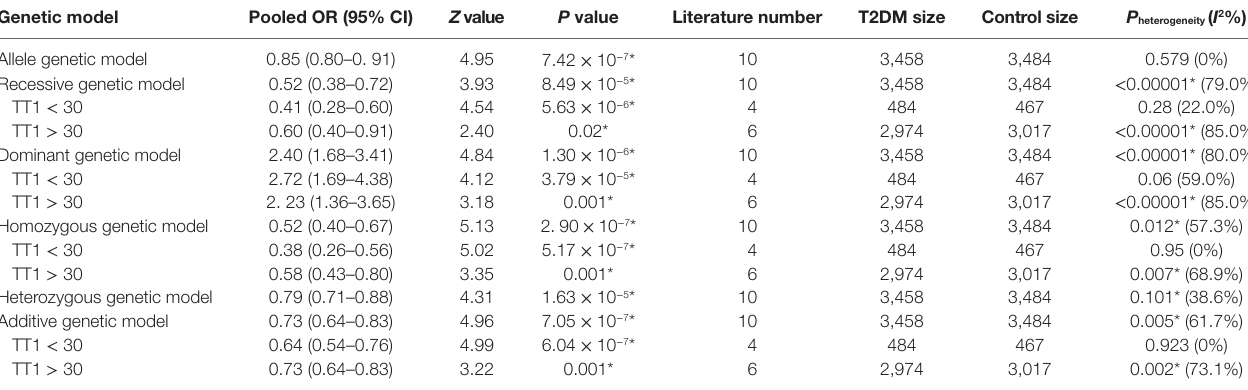
taBLe 2 | Summary of meta-analysis of association between SLC30A8 gene 807C/T (rs13266634C/T) polymorphism and T2DM in the Chinese population. Genetic model Pooled OR (95% ci) Z value P value Literature number t2Dm size control size P heterogeneity ( I 2 %) Allele genetic model